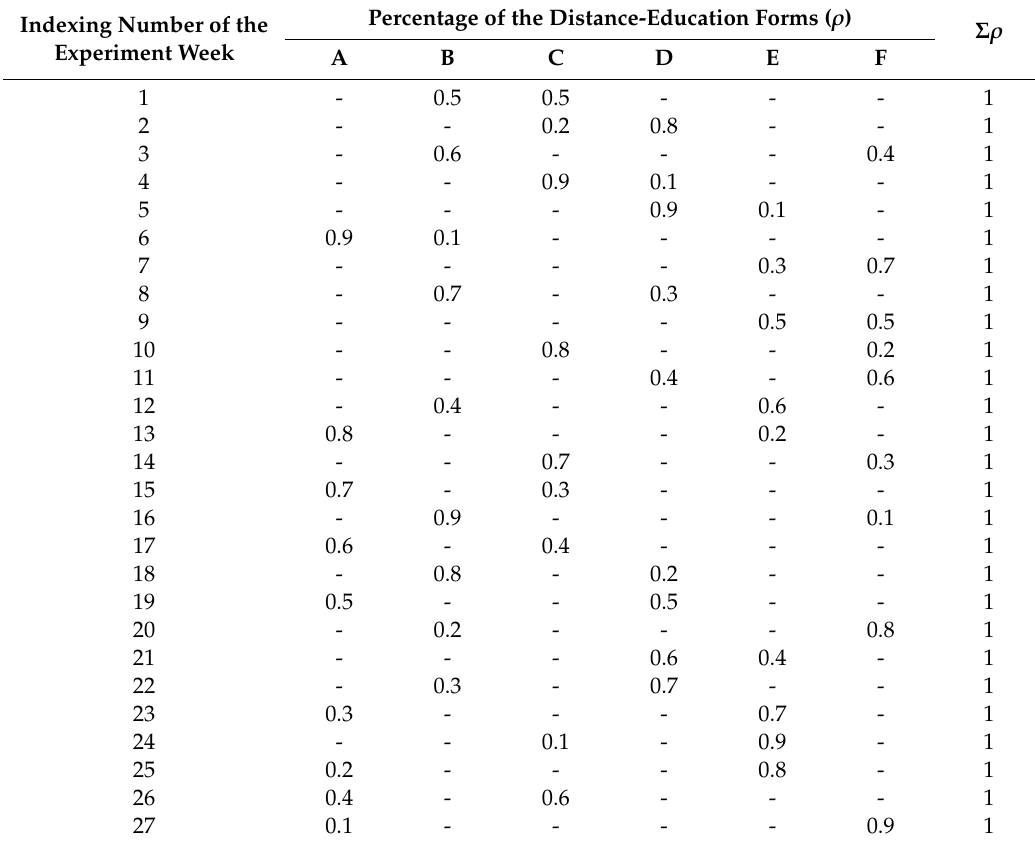
Table A6. Schedule for conducting an experiment to improve the distance-learning e ff ectiveness at the university: a case study of learning the discipline “Metallurgical Machines and Equipment”. Indexing Number of the Experiment